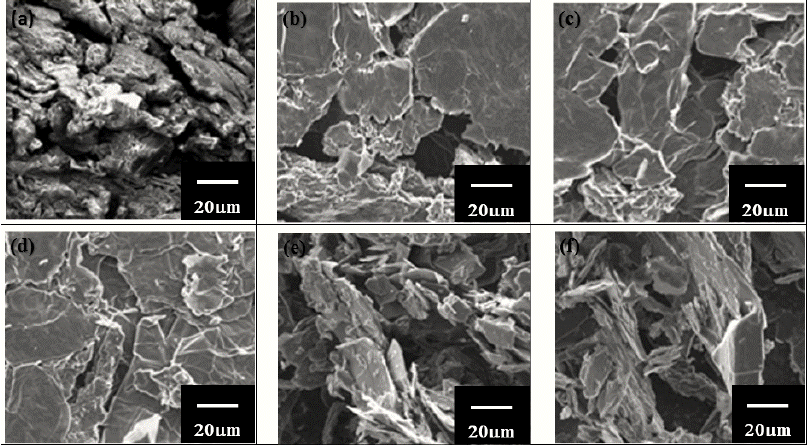
Figure 4. FESEM images of ( a ) GO; GO electrochemically reduced at ( b ) 5 V; ( c ) 10 V; ( d ) 15 V; ( e ) 20 V; and ( f ) 25 V.